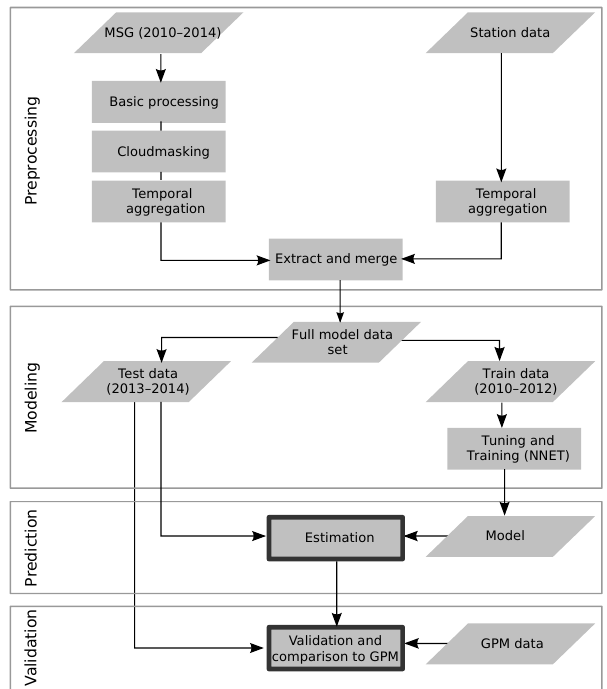
Figure 1. Flow chart of the methodology applied in this